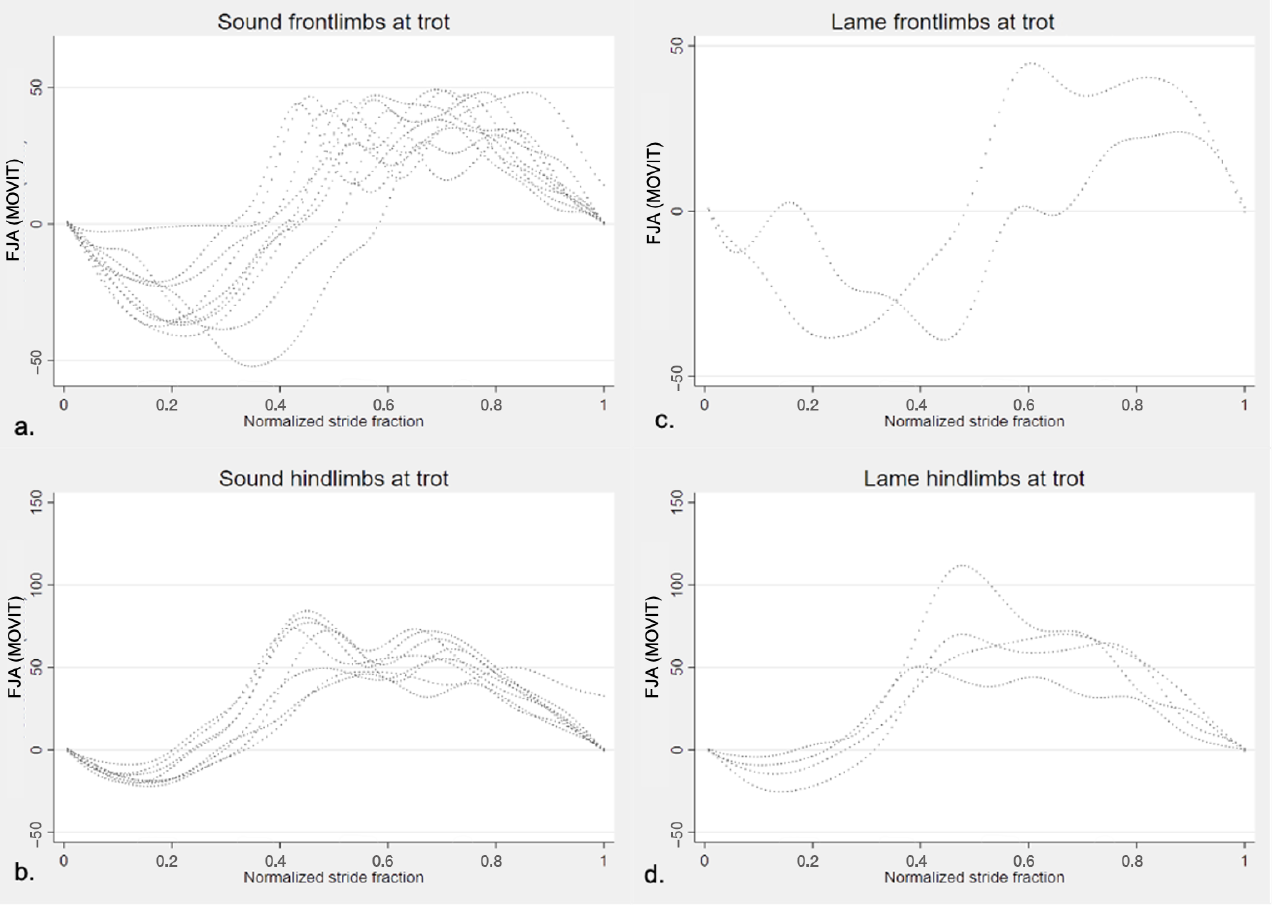
Figure 7. Fetlock joint angle pattern of one entire stride (normalized) of the horses in the study quantified by MOVIT IMU system at trot. Positive values of angles (°) represent flexion and negative values extension of the fetlock joint. ( a ) left and right sound forelimbs ( n = 14); ( b ) left and right sound hindlimbs ( n = 14); ( c ) lame forelimbs ( n = 2); ( d ) lame hindlimbs ( n = 4).